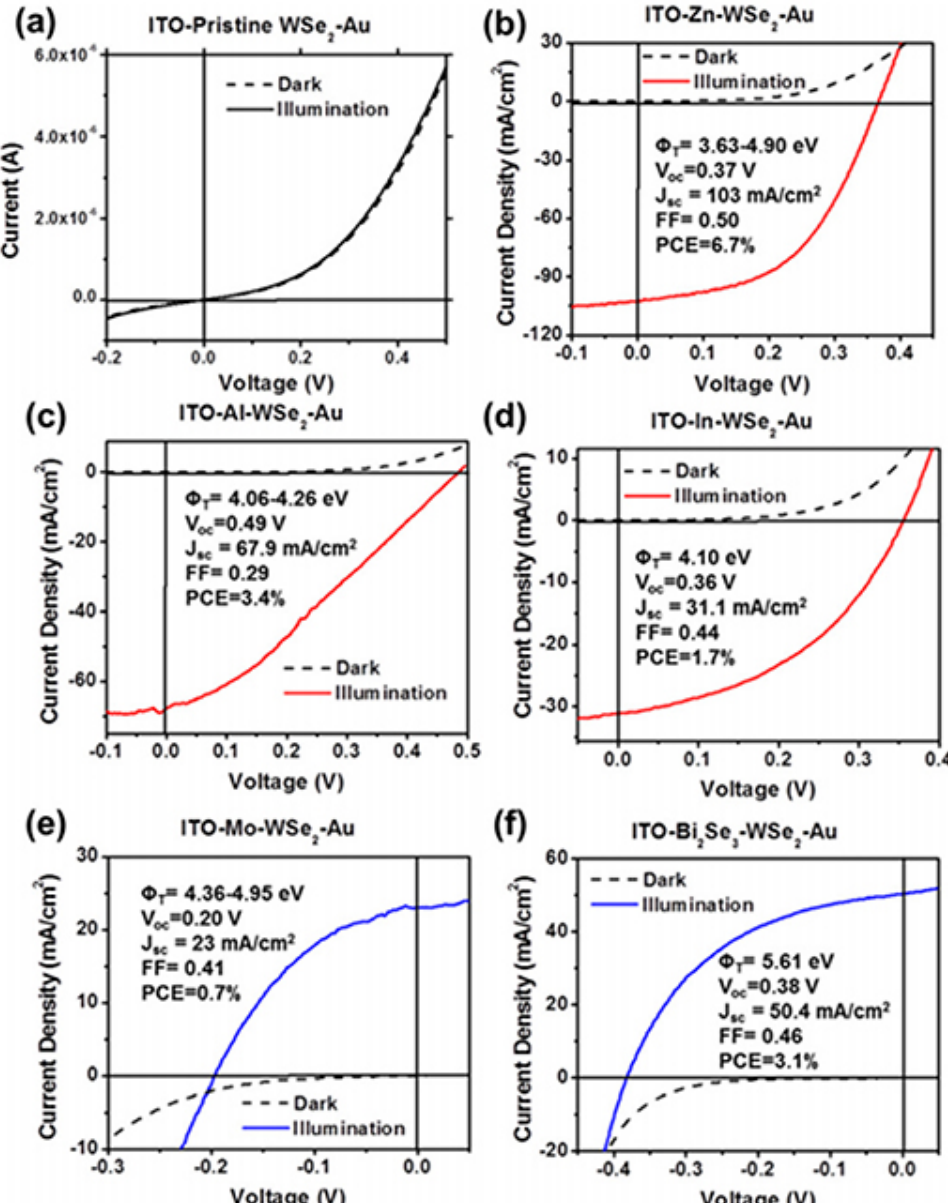
Figure 8. Photovoltaic characteristics of representative WSe 2 PV devices coated with various top metals, including ( b ) Zn, ( c ) Al, ( d ) In, and ( e ) Mo, as well as ( f ) semimetal Bi 2 Se 3 nanocrystals. ( a ) Result from a control device with no top metal coating. Reprinted (adapted) with permission from Reference [144], Copyright (2015), AIP.